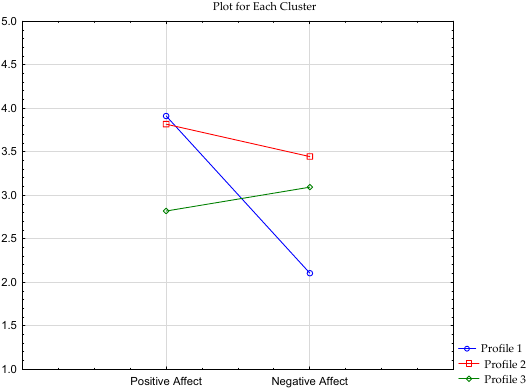
Figure 3. Clusters of PANAS Scale in the sample of respondents.